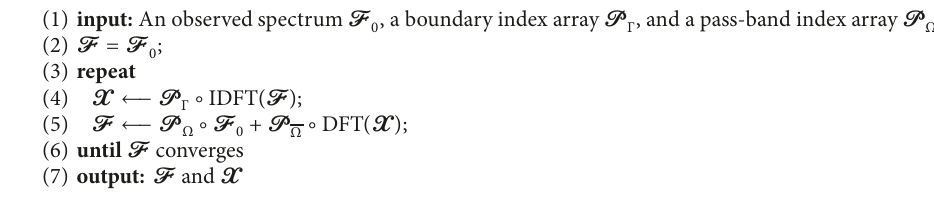
Algorithm 1: Gerchberg algorithm [7,